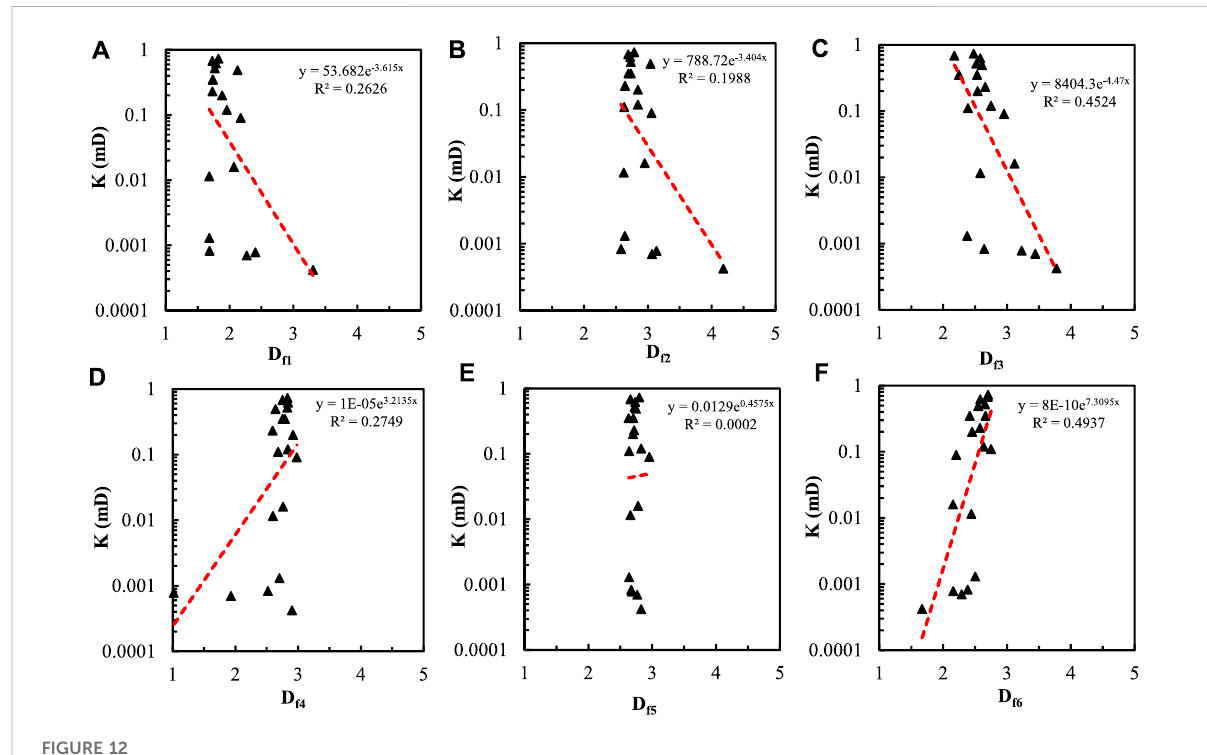
FIGURE 12 Relationship between permeability and fractal dimension calculated by six